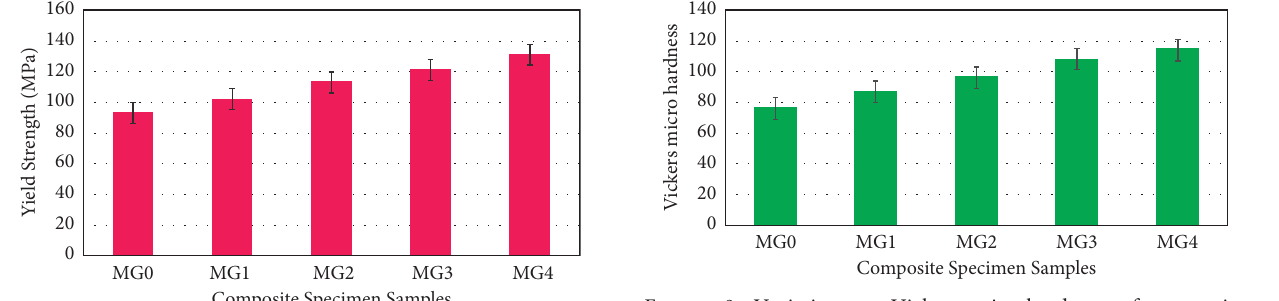
Figure 9: Variation on Vickers microhardness of composite specimens. Figure 7: Variation on the yield strength of composite specimens.